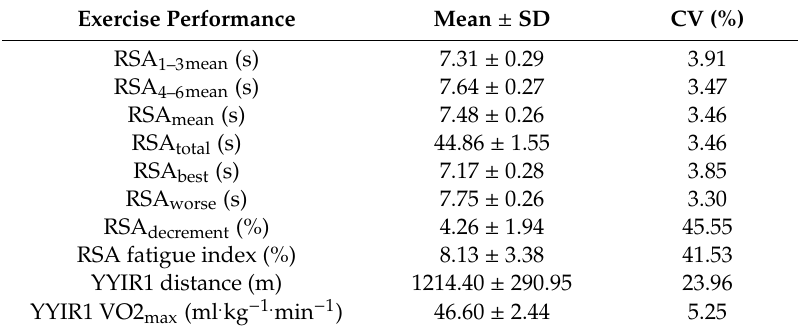
Table 1. Descriptive data of exercise performance of the